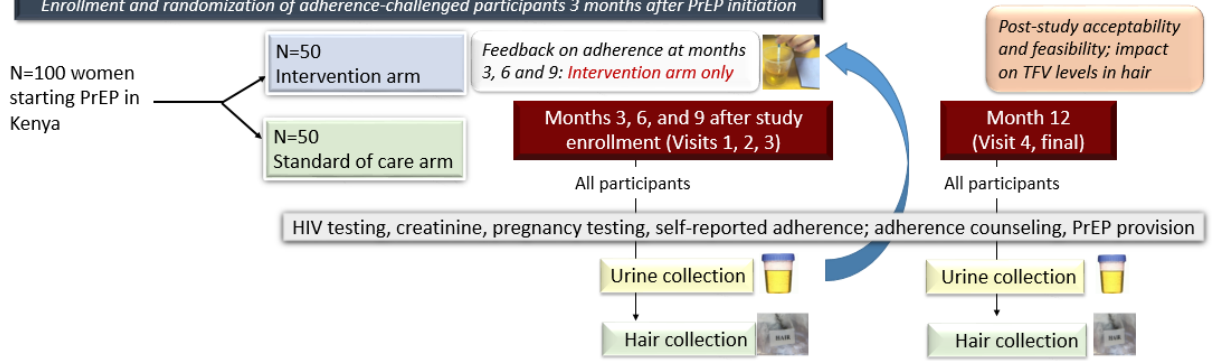
Figure 3. Schedule of evaluations for participants in the intervention and standard of care arms for the PUMA study. PUMA: Point-of-Care Urine Monitoring of Adherence; PrEP: preexposure prophylaxis; TFV: